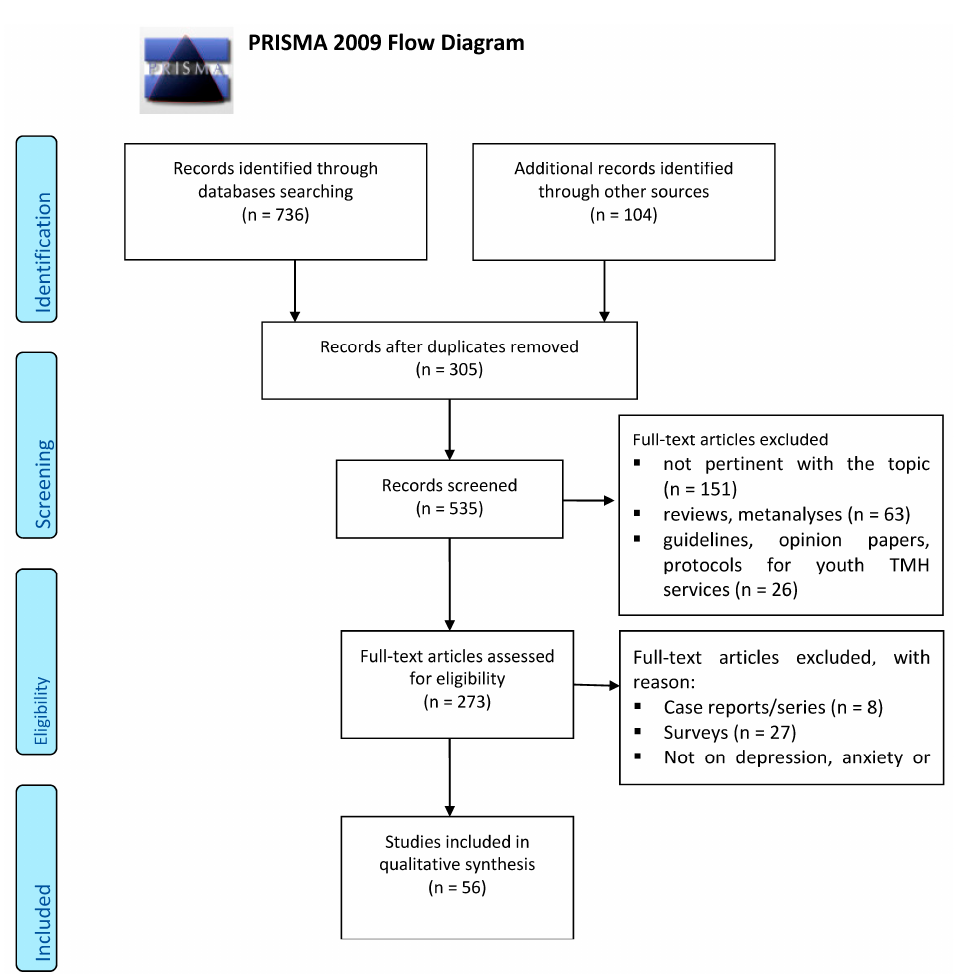
Figure A1. PRISMA 2009 Flow Diagram.